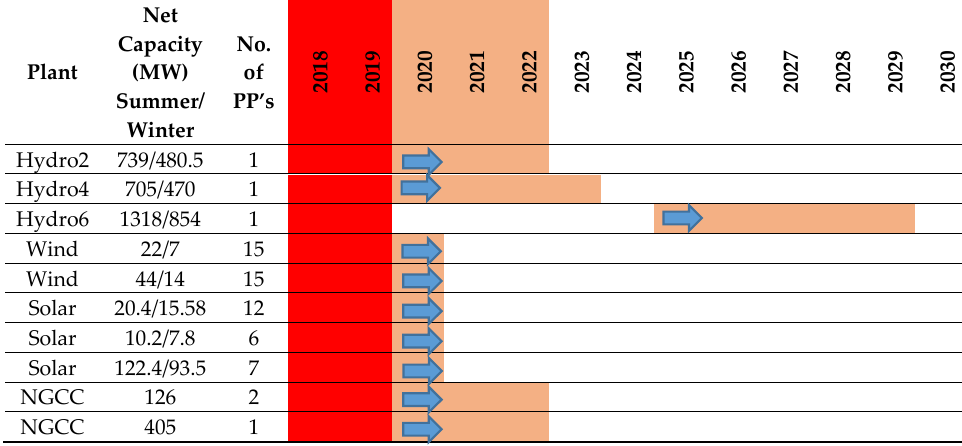
Table A6. Details of the Plants Installation under Capacity Expansion: Normal GDP Fuel Balancing (1–10%